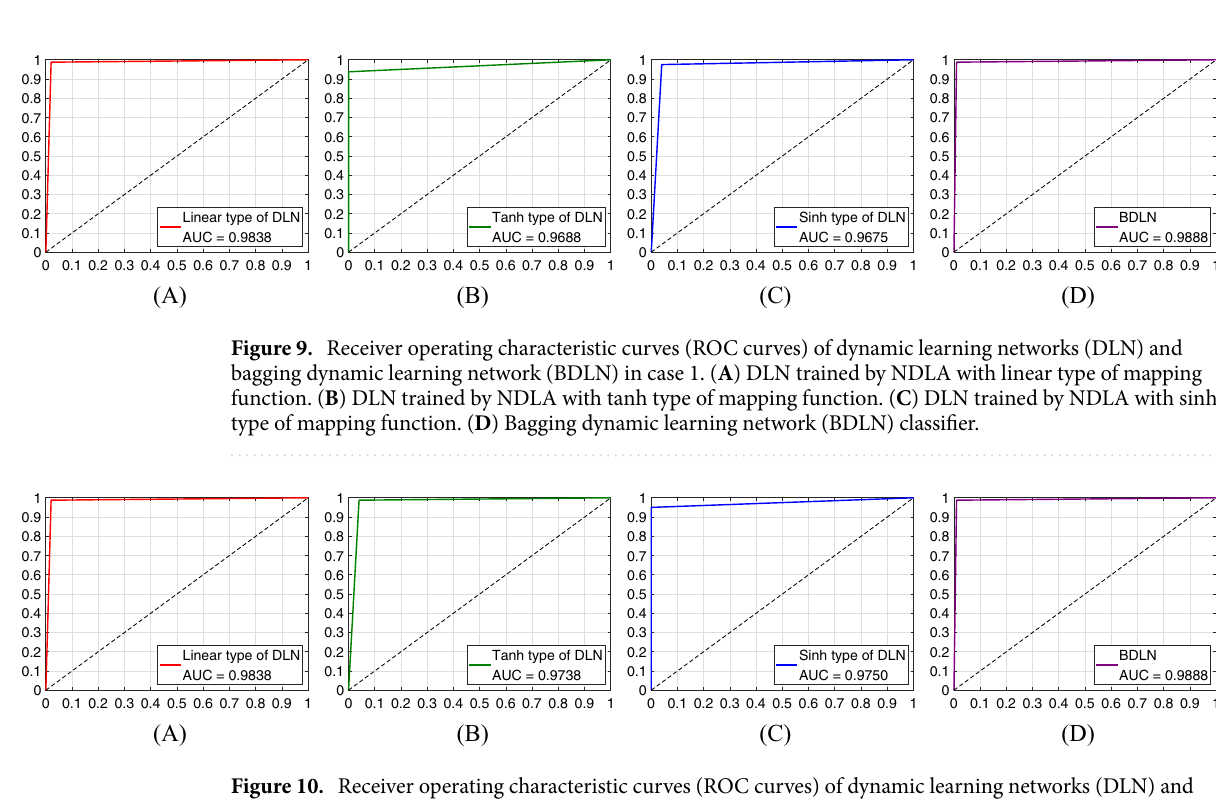
Figure 10. Receiver operating characteristic curves (ROC curves) of dynamic learning networks (DLN) and bagging dynamic learning network (BDLN) in case 2. ( A ) DLN trained by NDLA with linear type of mapping function. ( B ) DLN trained by NDLA with tanh type of mapping function. ( C ) DLN trained by NDLA with sinh type of mapping function. ( D ) Bagging dynamic learning network (BDLN)